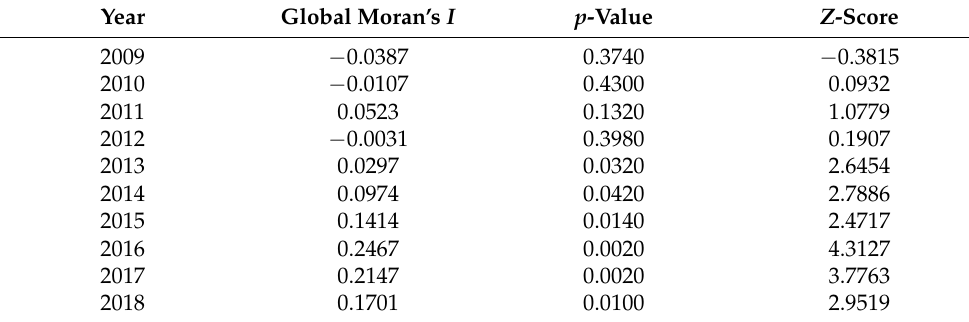
Table 3. Global Moran’s I Index of LUE in the Yellow River Basin.